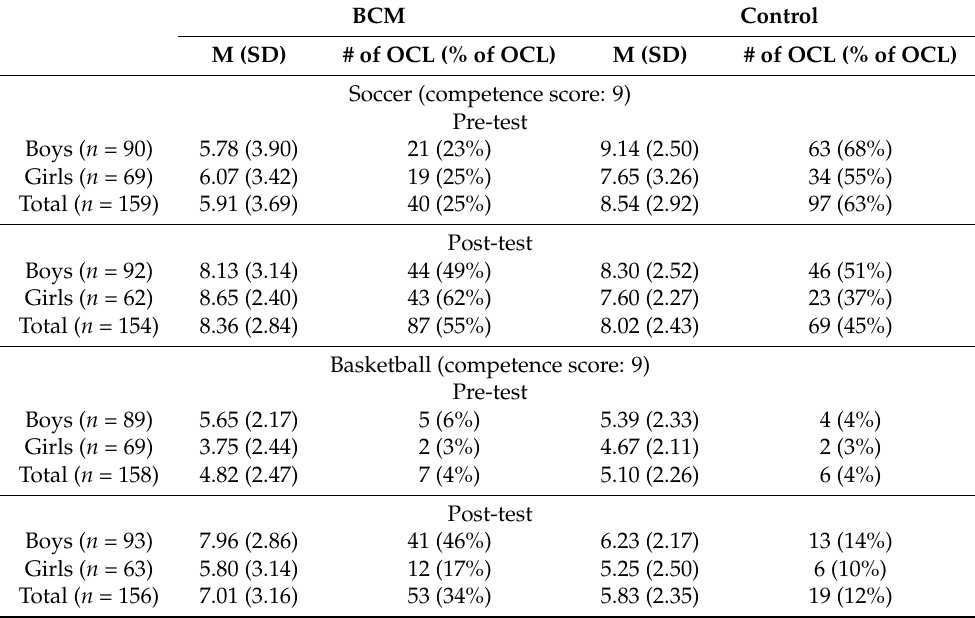
Table 1. Manipulative skill assessment performance of the students in the two cohorts. BCM